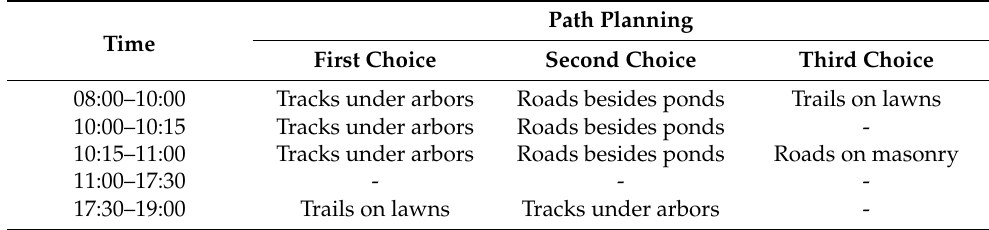
Table 6. Recommended path planning during the